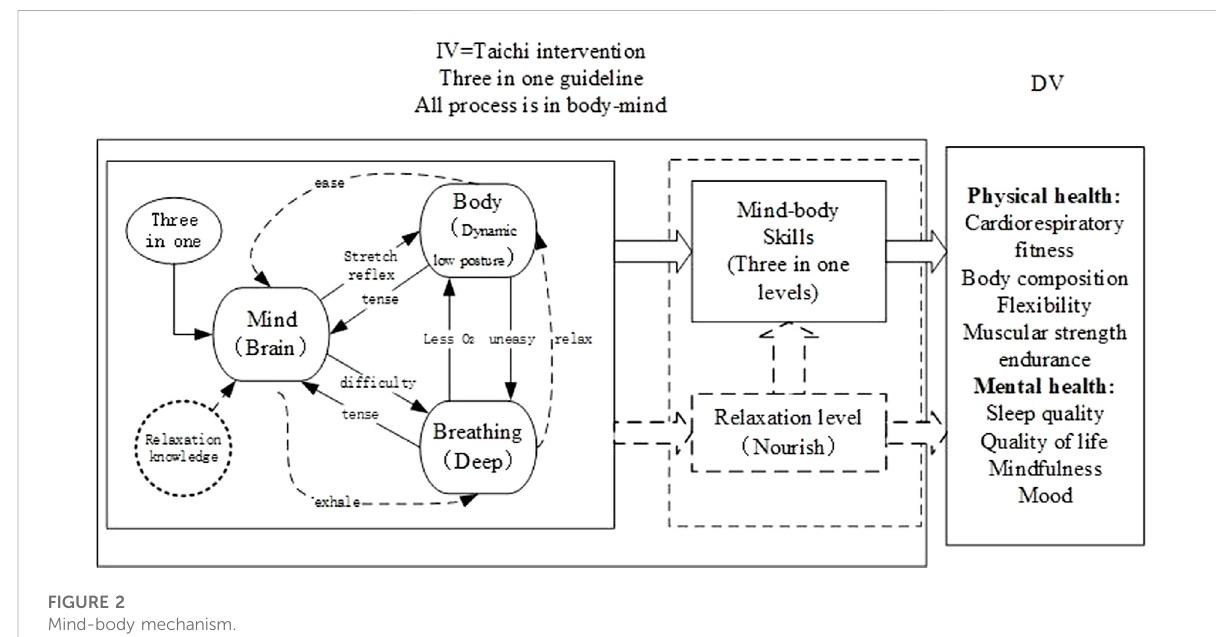
FIGURE 2 Mind-body